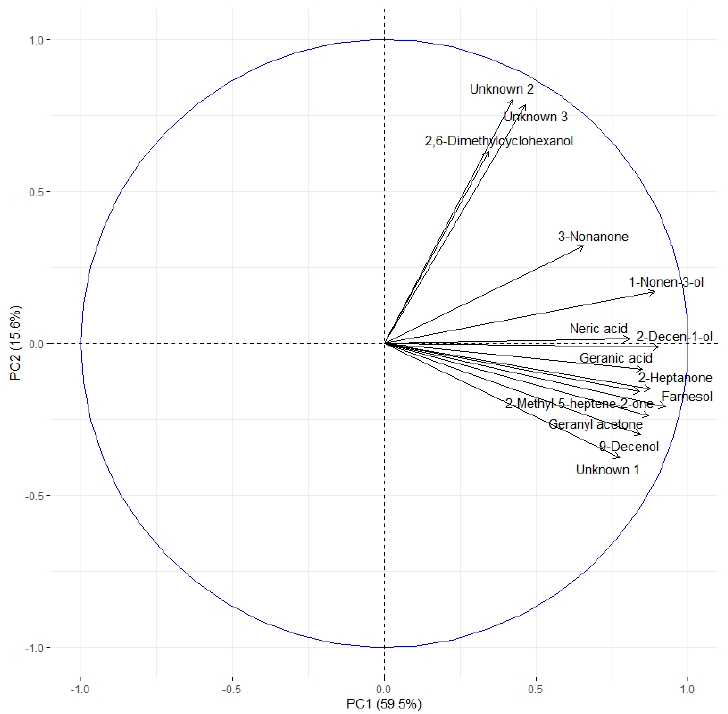
Figure 4. Correlation circle based on the 14 discriminating VOCs. Two clusters can be identified. The first contains 11 of the 14 discriminating VOCs. The second one contains three compounds (2,6-dimethylcyclohexanol and unknown compounds 2 and 3). Considering the evolution of the signal abundance, the first cluster can be related to the fipronil exposure and the second cluster to the exposure duration.